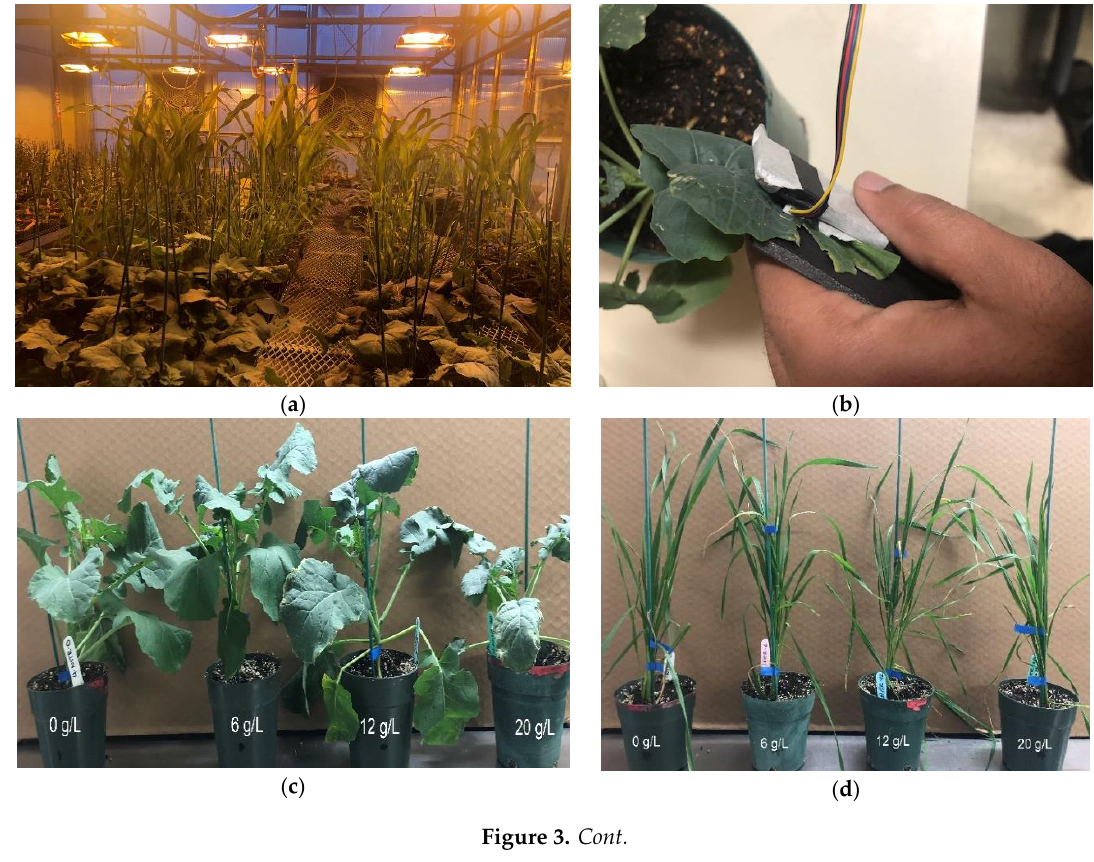
Figure 2. Connection overview of the proposed device. Sensor1 and Sensor2 were connected to Port1 and PORT2 of the MUX through Qwiic connectors. The four lines from the main port of the MUX were connected to the SDA, SCL, VCC, and GND of the control circuit. The power bank was connected to the micro-USB port of the control circuit, and the organic light-emitting diode (OLED) display was connected to the SDA and